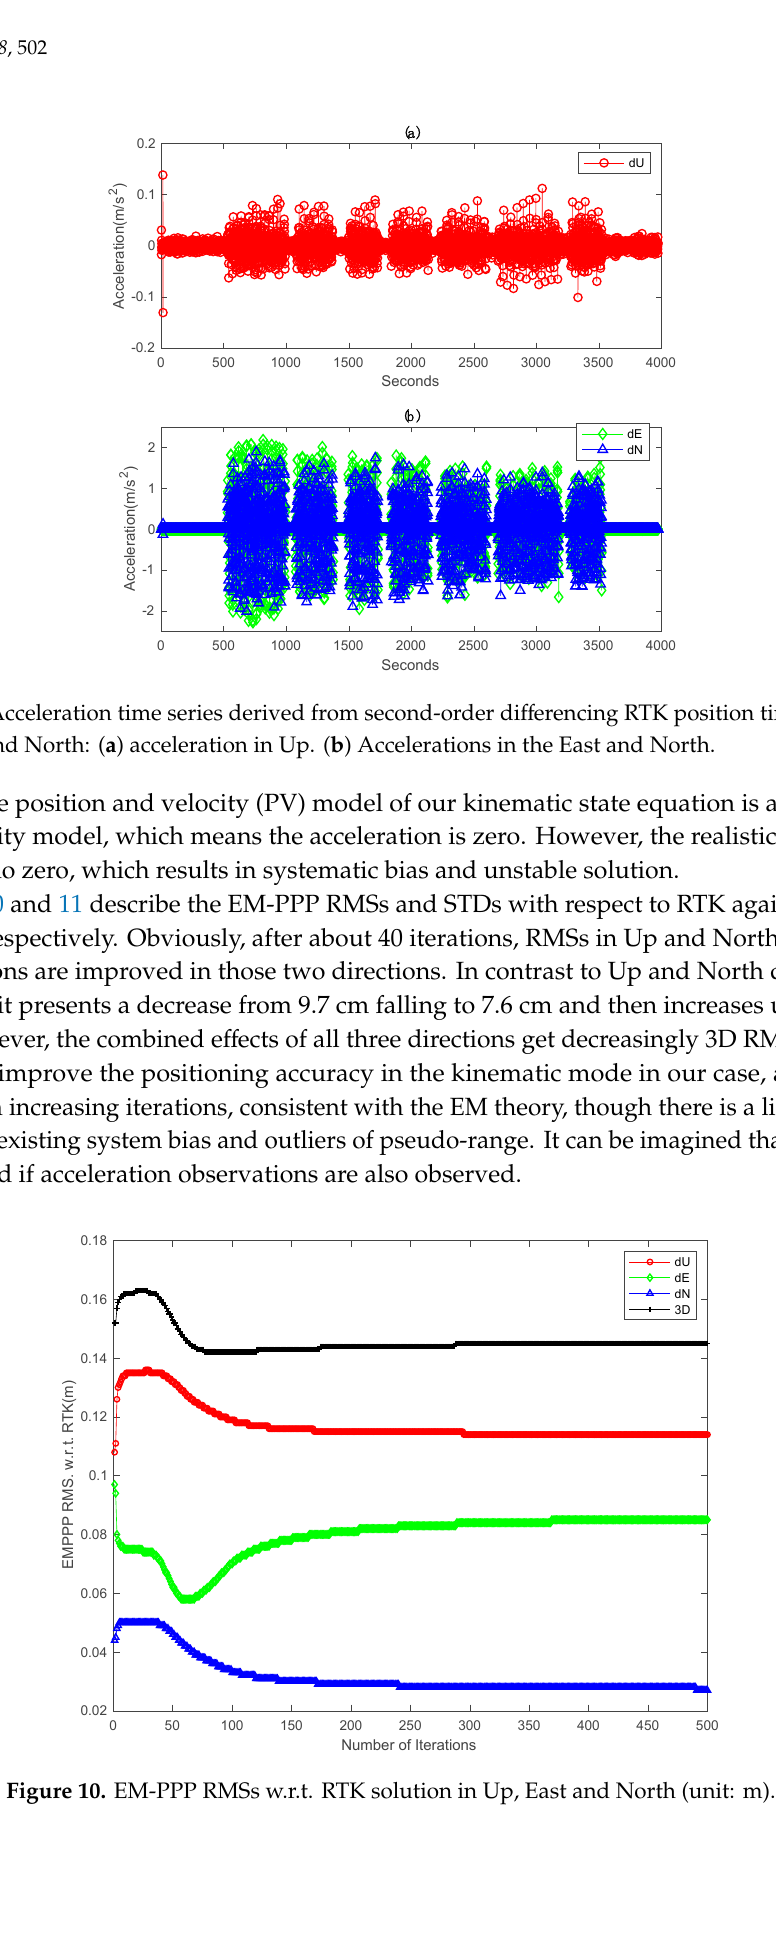
Figure 8. GPS-only kinematic positioning errors with respect to real-time kinematic (RTK): ( a ) traditional PPP errors, ( b ) EM-PPP positioning errors at the 500th iteration. Traditional PPP and EM-PPP share the same initial conditions.